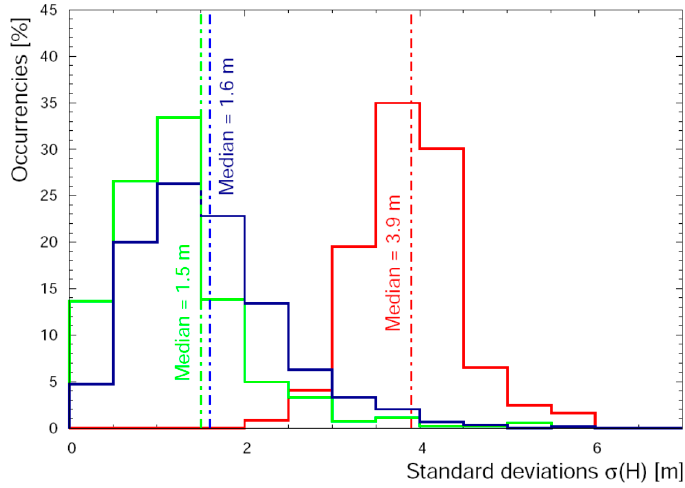
Figure 14. Distribution of σ (H) (standard deviations of heights) in the altitude ranges (35–66) m (red solid line), (79–340) m (blue solid line) and (340–2194) m (green solid line) measured at 0.2 Hz.